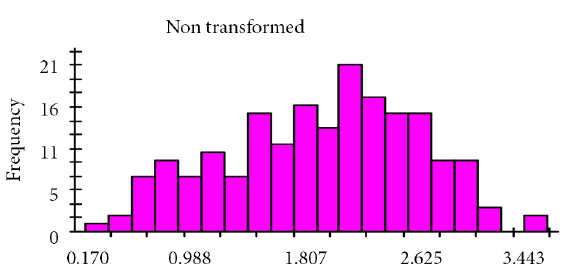
Fig. 3. Distribution graph of PI parameters (represents the distribution is almost normal)